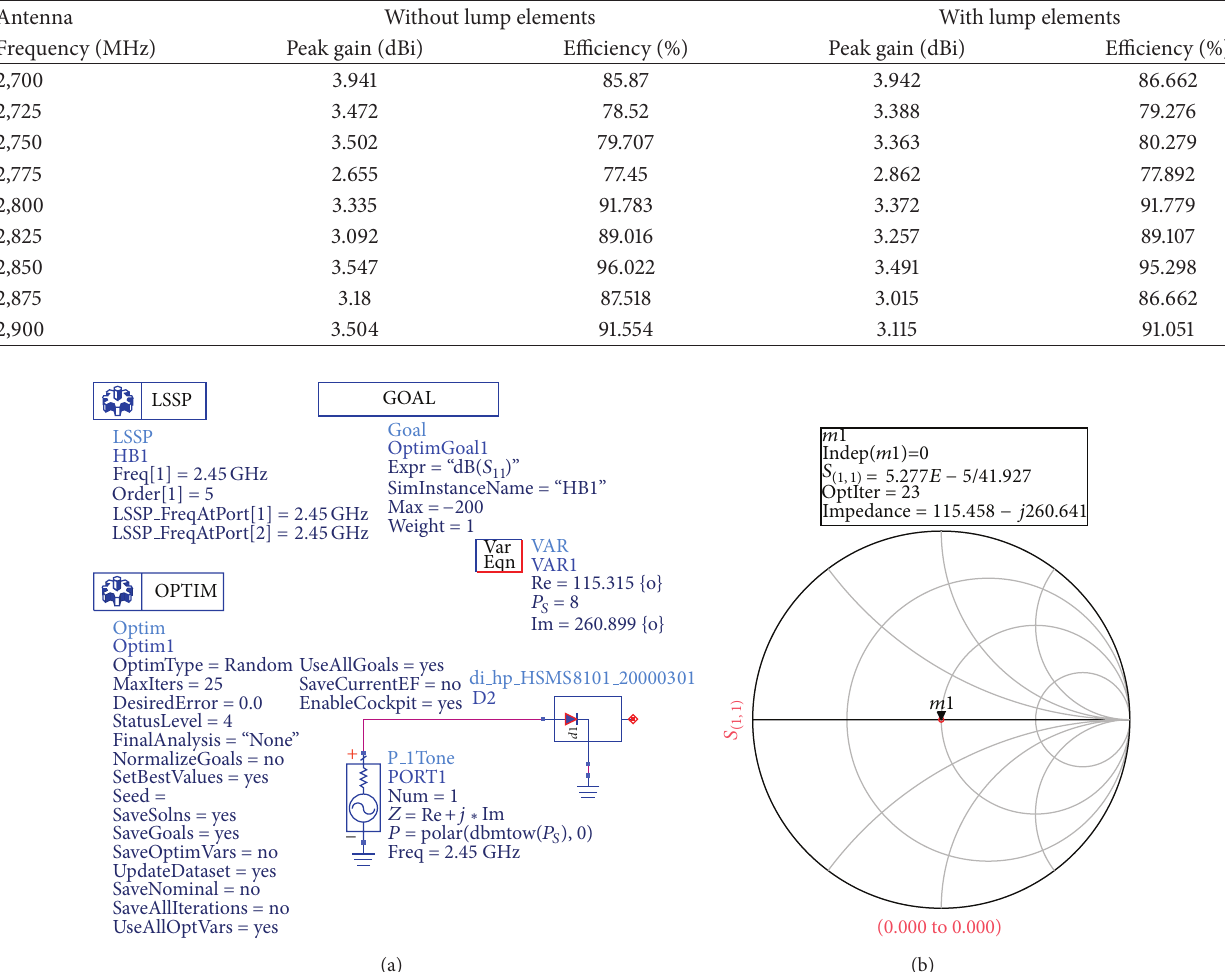
Table 2: Peak gain and efficiency measurement results of the antenna without and with lump elements.